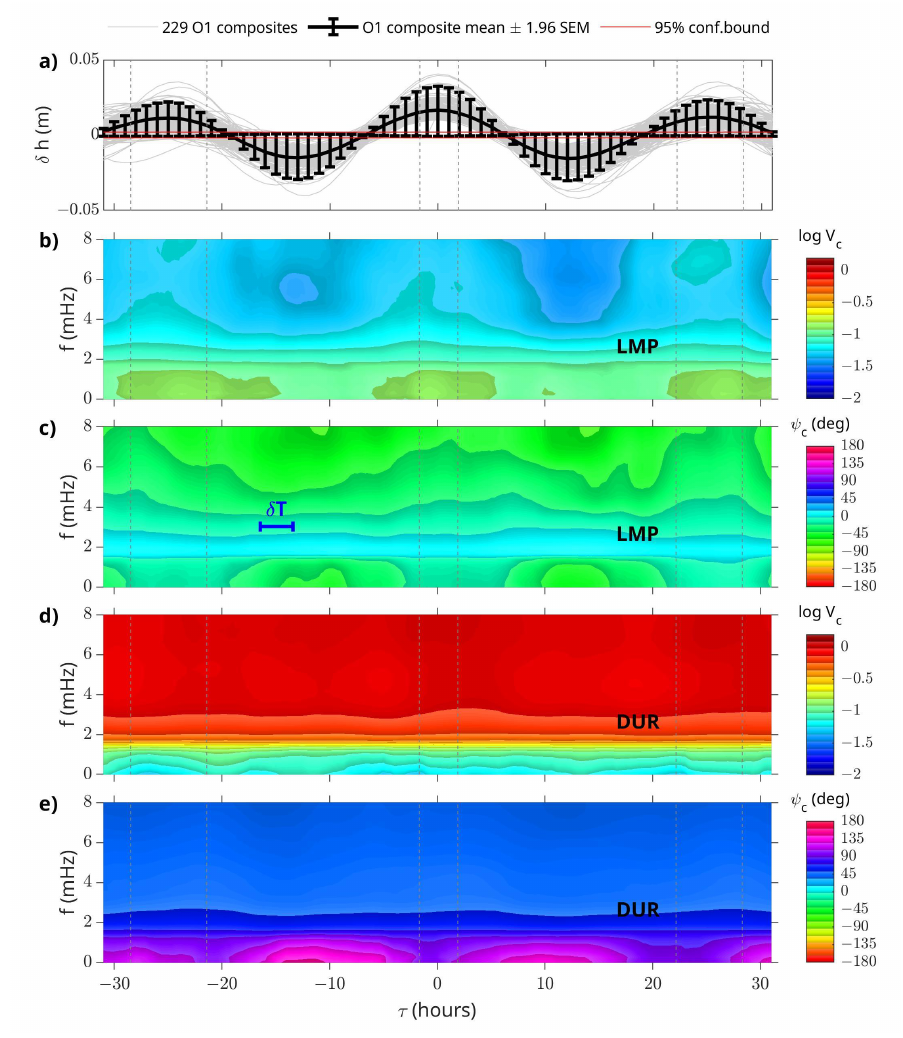
Figure 7. SEA results of SSIA at DUR and LMP. Panel ( a ): superposition of 229 tidal events (gray lines) during 2017–2020 at periods of ∼ 26 h and their composite mean (black line). Panels ( b , c ): composite means of log-scale amplitude V c and phase ψ c at LMP. Panels ( d , e ): same as panels ( b , c ) but for DUR. The horizontal blue bar in panel ( c ) indicates the time uncertainty δ T ∼ 3 h functional to the spectral analysis (see text for details). The vertical dashed gray lines mark the uncertainty in determining τ (i.e., τ ± ∆ τ ) in correspondence of maximum δ h of each composite. The correlation coefficients r and the results of the linear regression between δ h and both V c and ψ ( ∝ αδ h + β ) are reported in Figure 8. The α values show that an amplitude c increase of δ V c ∼ 4 × 10 − 3 ( ∼ 5 × 10 − 3 ) and an azimuthal increment of δψ are expected for δ h = 1 cm for f > 2 mHz (<1.3